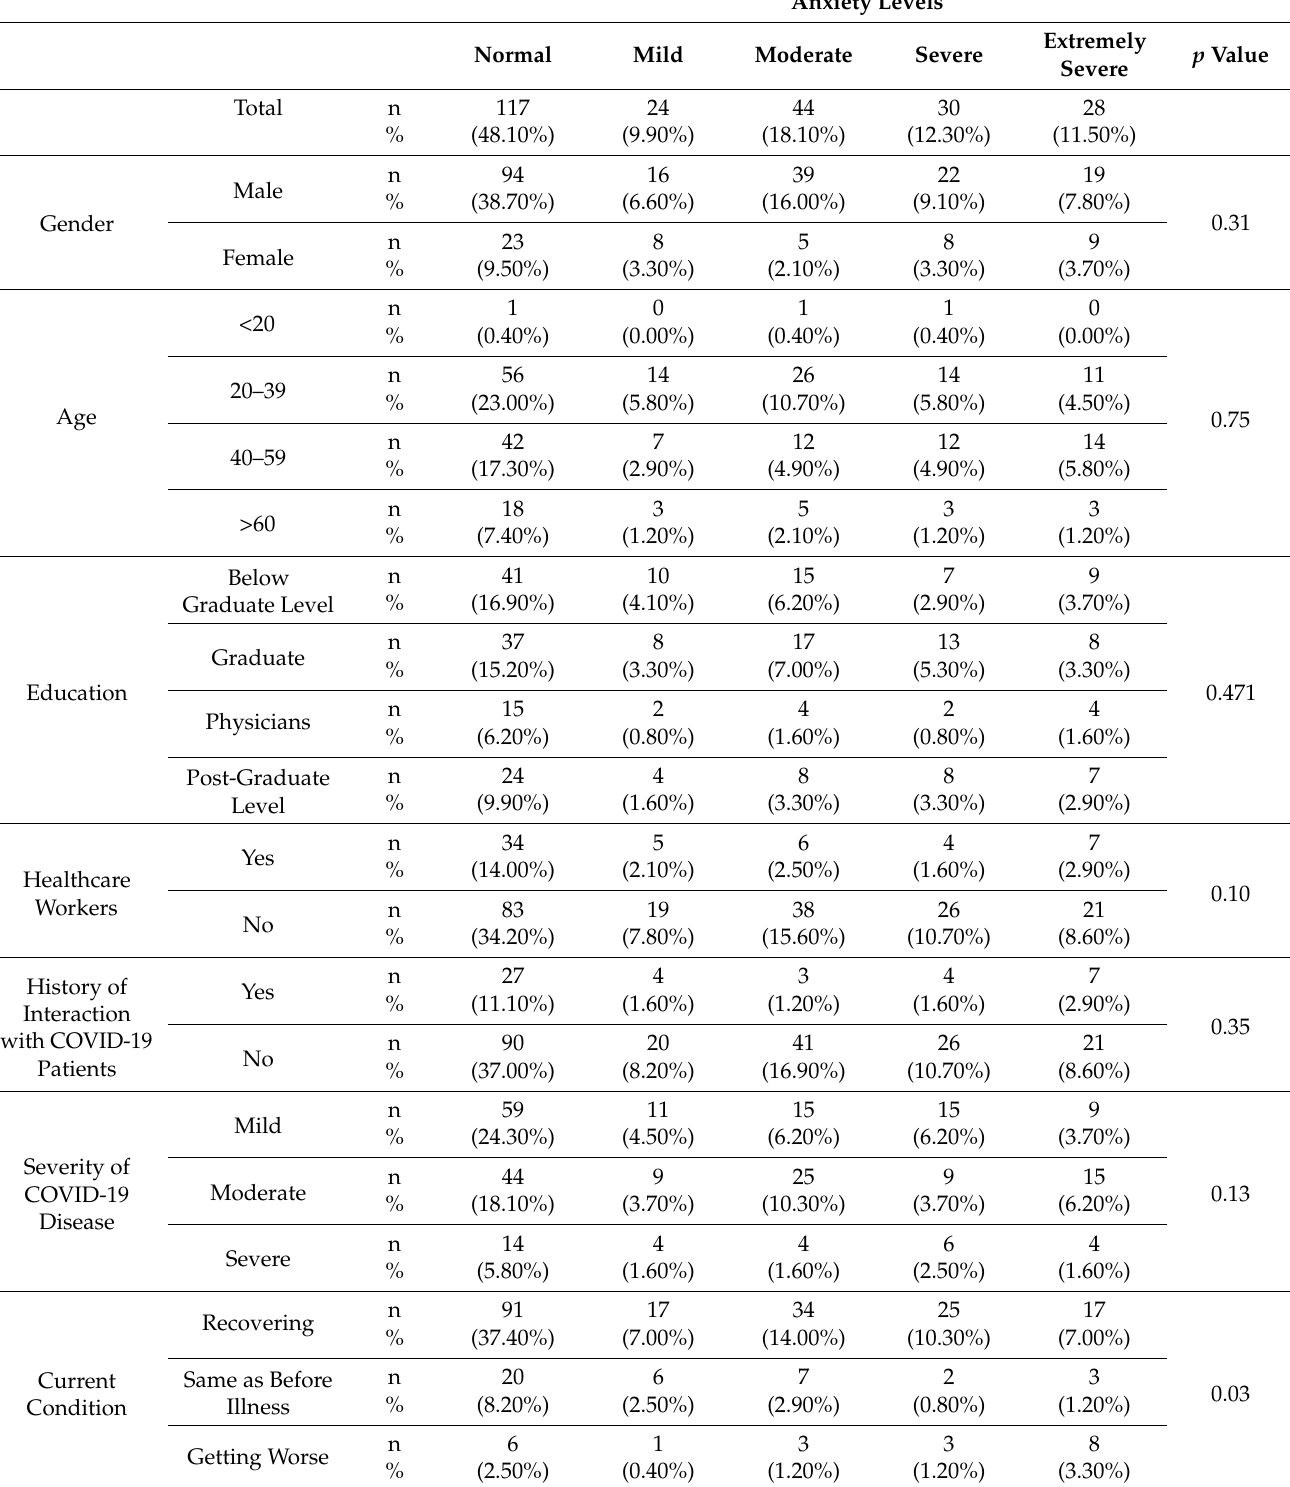
Table 1. Percentage distribution of demographics and anxiety